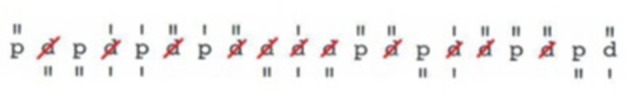
Sample row of the d2-R test.